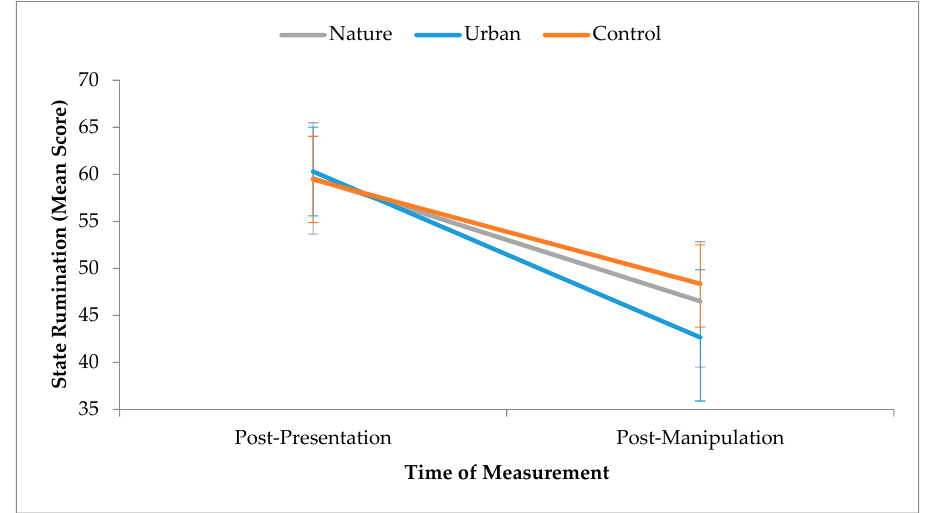
Figure 3. Effect of time on state rumination by condition. Error bars represent 95% confidence intervals.